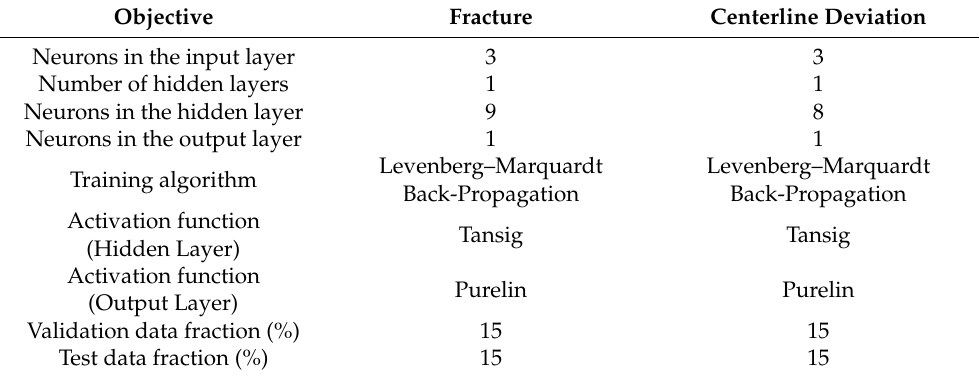
Table 3. Parameters of trained ANNs.